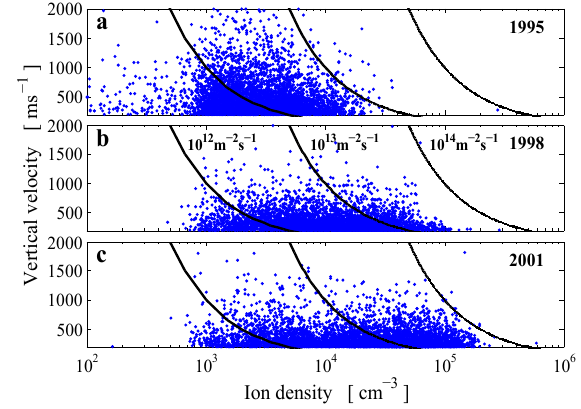
Figure 7. Scatter points of ion density versus upward drift at the conditions of low (1995, P ∼ 71.6), moderate (1998, P ∼ 118.1) and high solar activity (2001, P ∼ 181.3). The bold solid lines are the ion flux with values of 10 12 , 10 13 , 10 14 m −2 ·s −1 , respectively, from left to